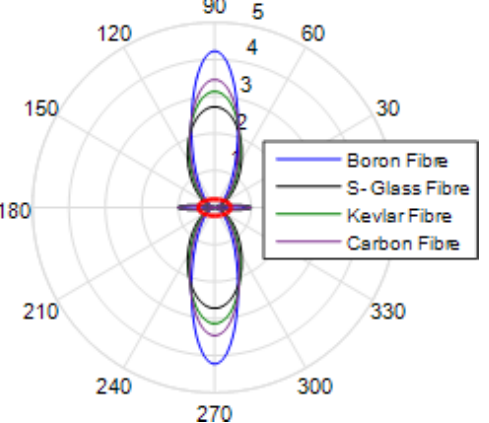
Figure 12: Effect of fibre materials on σ θ ( σ ∞ x = 1 , [0 /90]s)